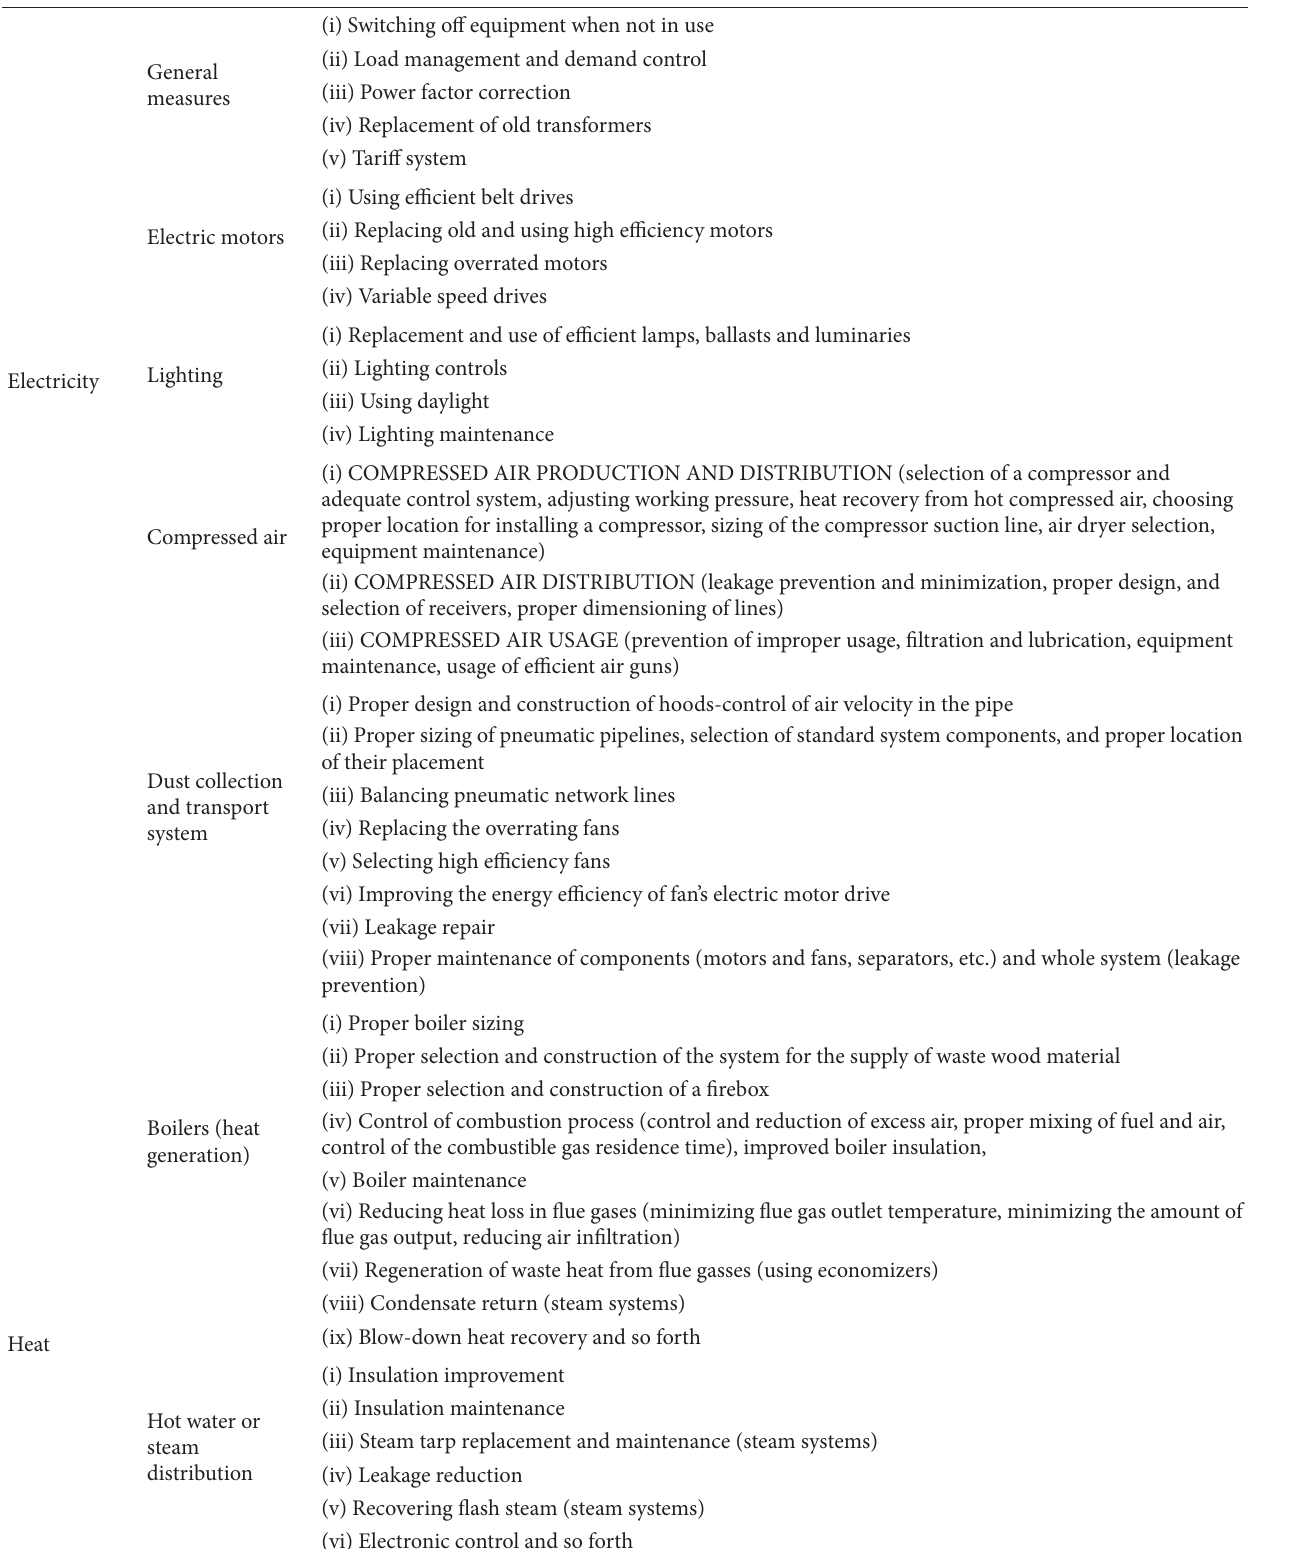
Table 6: Opportunities and measures for energy savings in wood furniture industry